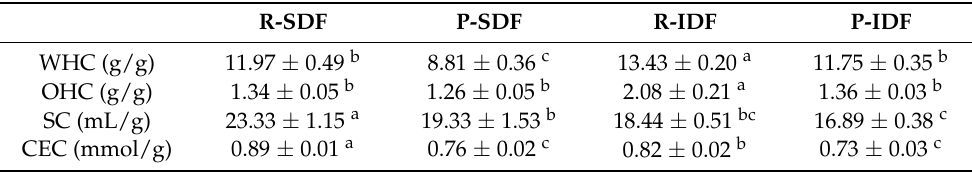
Table 2. Physiochemical properties of R-SDF, P-SDF, R-IDF and P-IDF. R-SDF P-SDF R-IDF P-IDF WHC